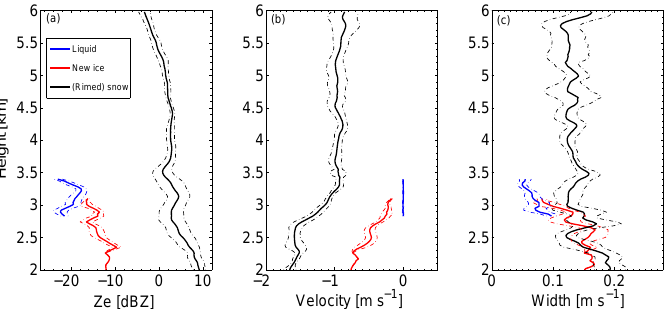
Figure 7. Slanted profile moments of SLW (blue), ice generated in the SLW layer (red), and frontal snow (black). Means and standard deviations of (a) reflectivity, (b) mean Doppler velocity, and (c) mode width are shown for the slanted paths encompassed by the two dashed lines in Fig. 5. Within the SLW layer, the velocities are corrected for vertical air